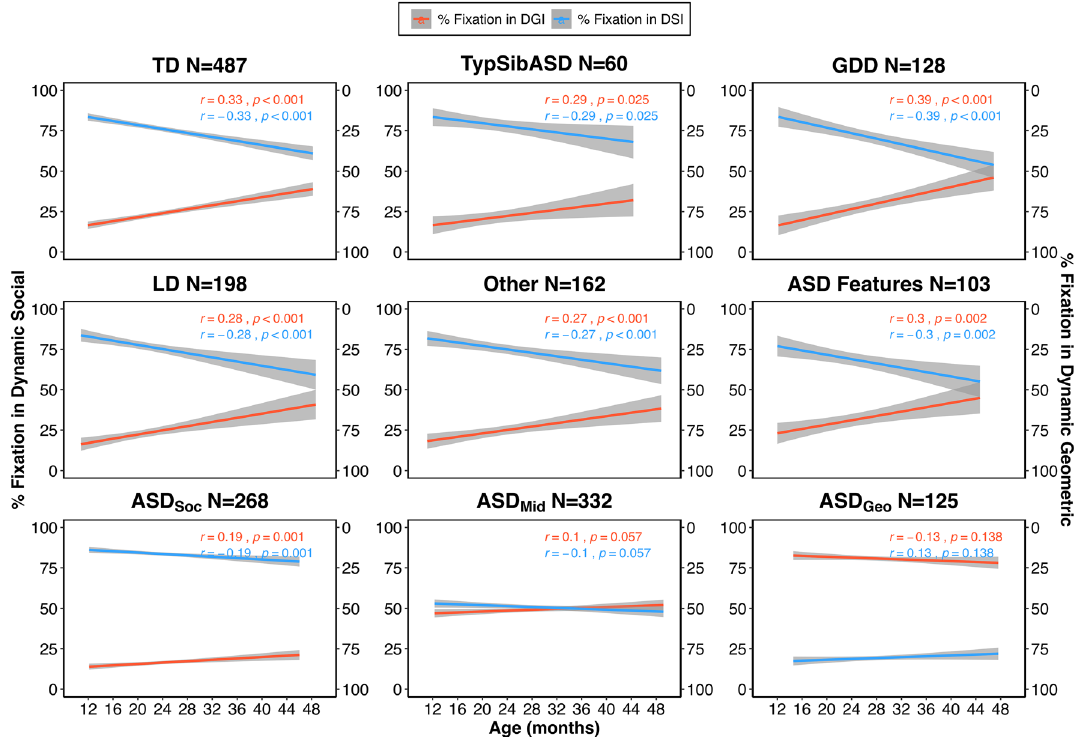
Figure 3. Developmental trajectories of social and non-social (geometric) attention distinguish ASD toddlers from toddlers of other developmental types. Best fit lines depicting developmental trajectories of percent fixation to social images (blue) or non-social images (red) for toddlers of different developmental types and associated Pearson’s r and p-values. ASD toddlers were again split into the three ASD subgroups based on visual attention preference for social (ASD Soc ) or non-social stimuli (ASD Geo ). ASD Mid toddlers did not exhibit a strong preference for social or non-social stimuli. ASD: Autism Spectrum Disorders, ASD-Feat: ASD Features,